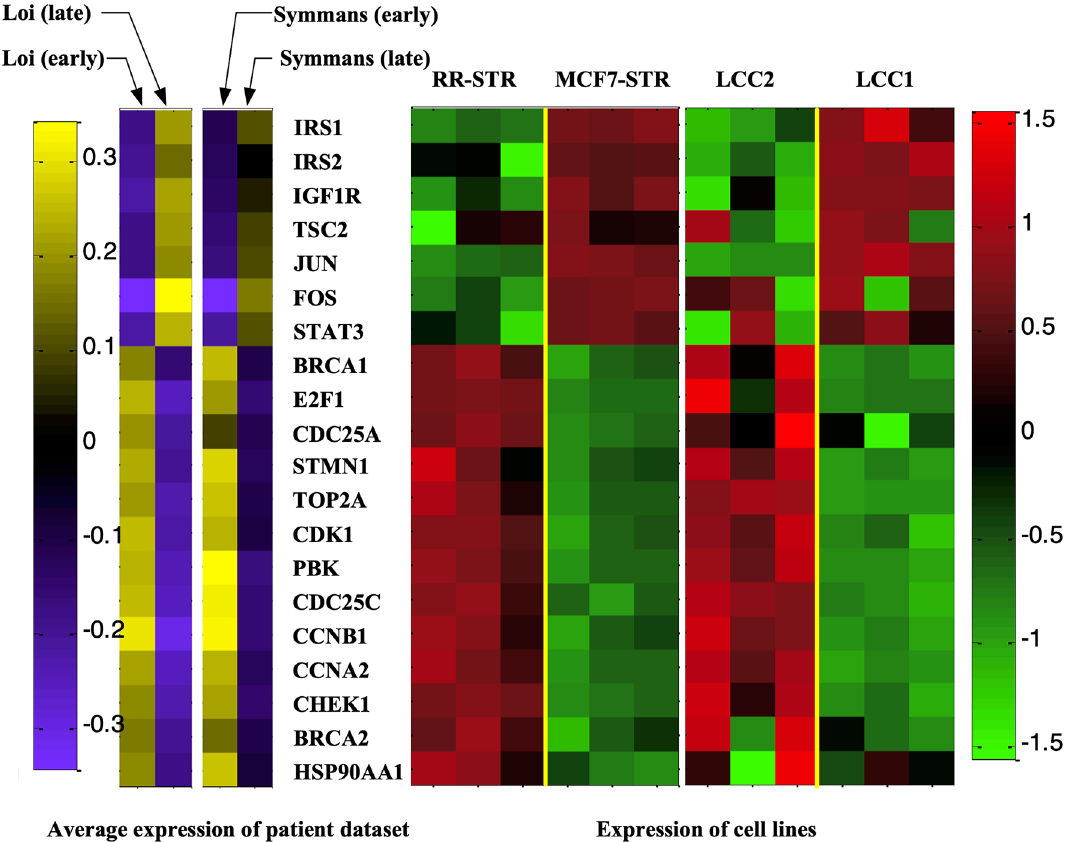
Figure 6. Cell line validation for identified pathway genes from patient datasets. The left panel shows the average log 2 expression of selected pathway genes. The right panel shows the log 2 expression of two cell line studies: (MCF7-STRP vs . MCF7RR-STRP and LCC1 vs. LCC2). Seven genes (IRS1, IRS2, IGF1R, TSC2, JUN, FOS, STAT3) are consistently over-expressed in the ‘early recurrence’ patient samples and sensitive human breast cancer cell lines. The remaining genes, which mainly relate to cell cycle and apoptosis, are over-expressed in the resistant